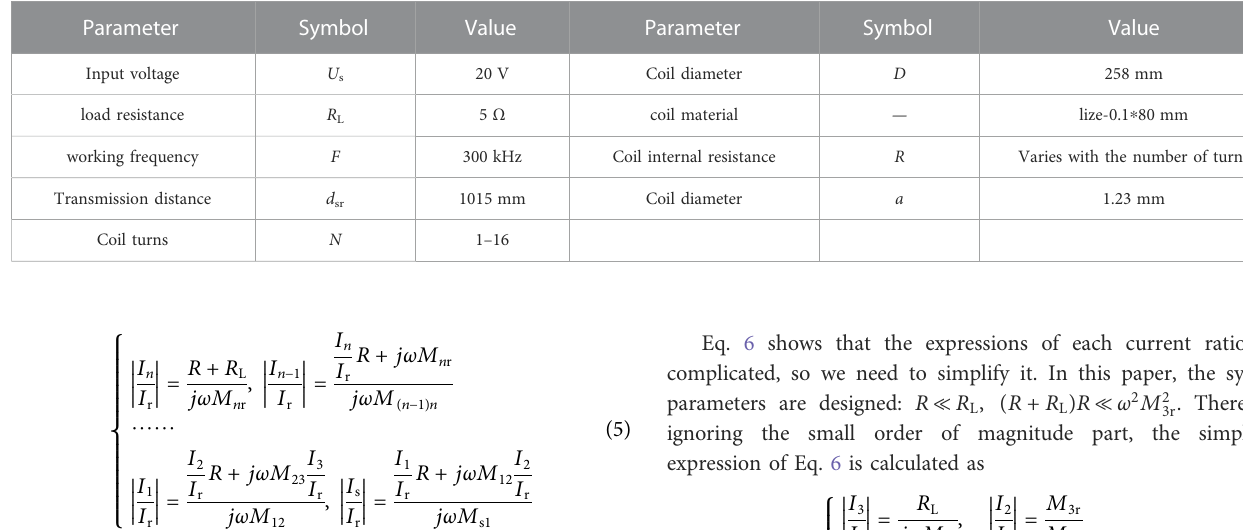
TABLE 1 System parameters.